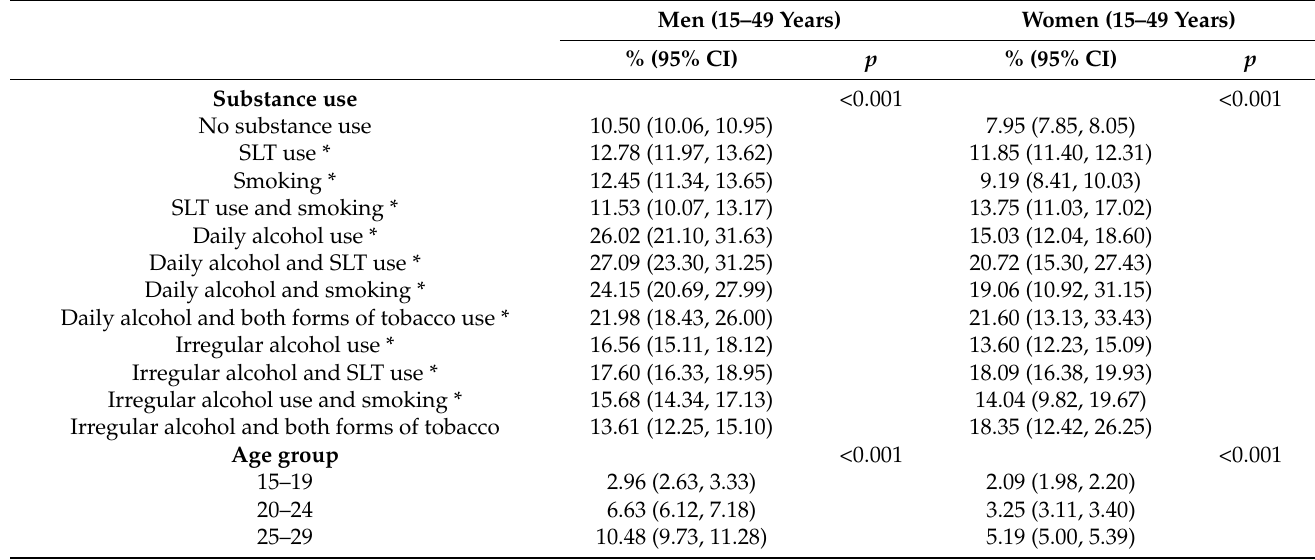
Table 2. Prevalence of hypertension among Indian men and women aged 15–49 years by key predictor and select correlates, India,